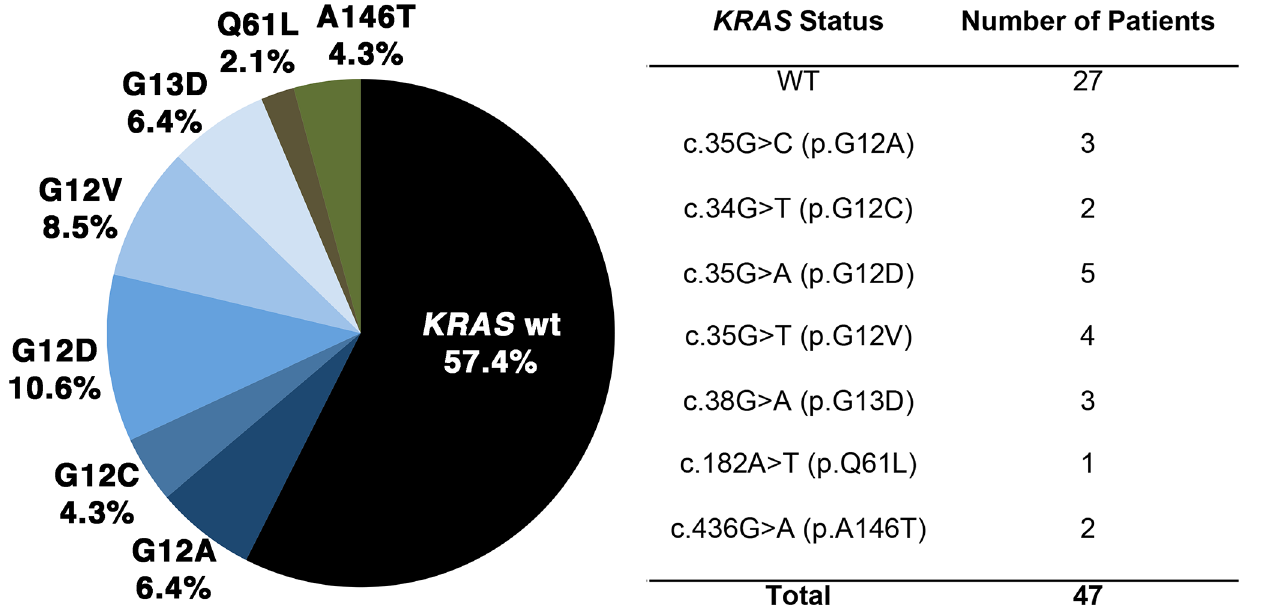
Fig 3. Distribution of KRAS mutation- and wild-type status in pre-therapeutic biopsies.